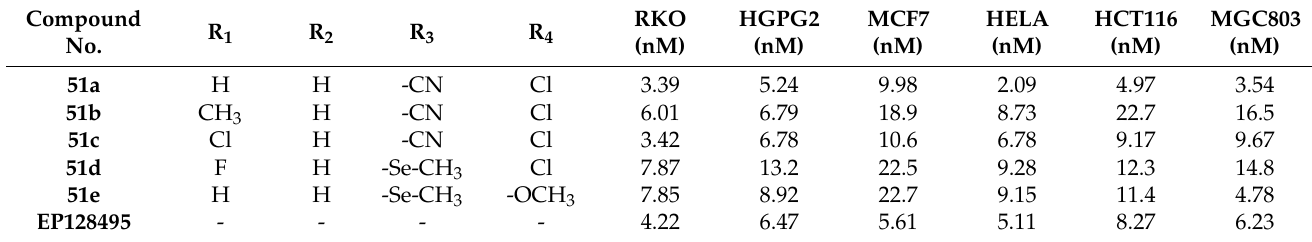
Figure 58. Structure of selenium based anilino quinazoline hybrid derivatives ( 51 ). Table 45. In vitro cytotoxic activities of selenium based anilino quinazoline hybrid compounds 51 ( a – e ).